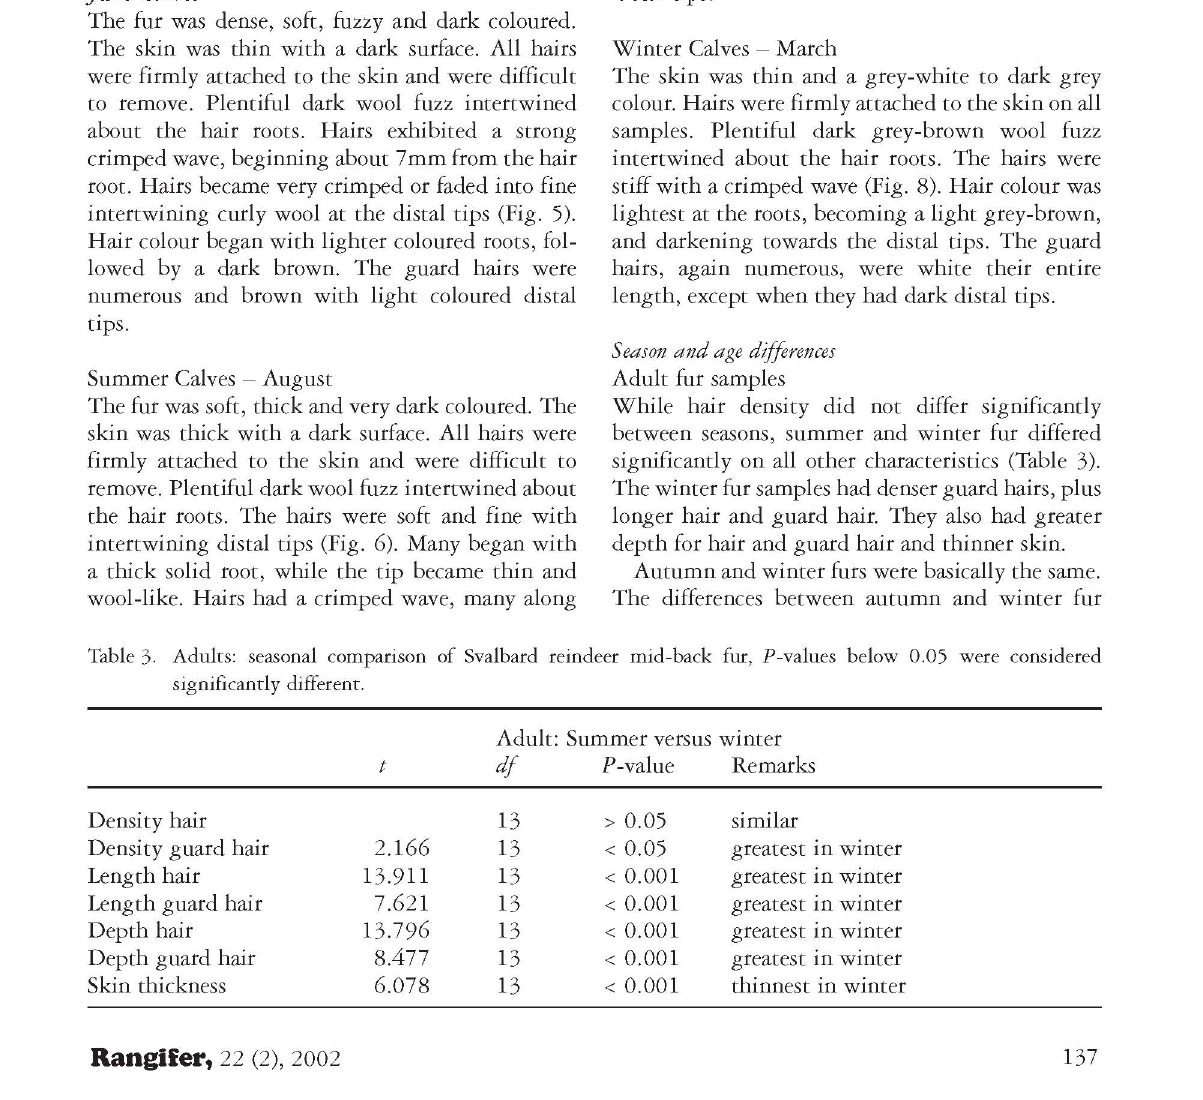
Table 3. Adults: seasonal comparison of Svalbard reindeer mid-back fur, P -values below 0.05 were considered significantly